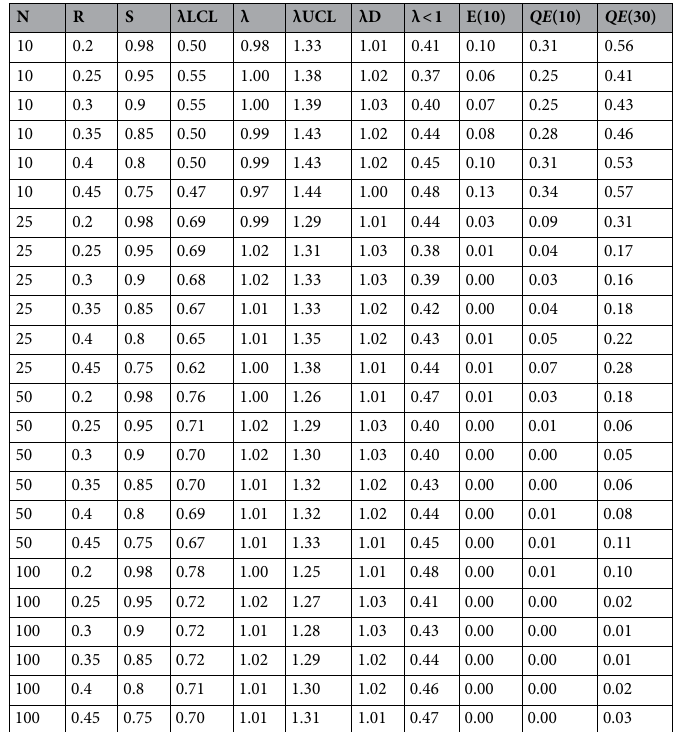
Table 2. Values of population abundance for adult females (N), recruitment (R), and survivorship of adult females (S) used in the 30-year population modeling simulations (10,000 simulations per R and S combination) to acquire mean population growth (λ) ~ 1.0, with lower and upper 90% CI’s (LCL, UCL), deterministic λ (λD), extinction probability at year 10 (E), quasi-extinction probability ( QE ; the probability that the population declines to ≤ 5 adult females at years 10 and 30), and the proportion of scenarios resulting in λ < 1.